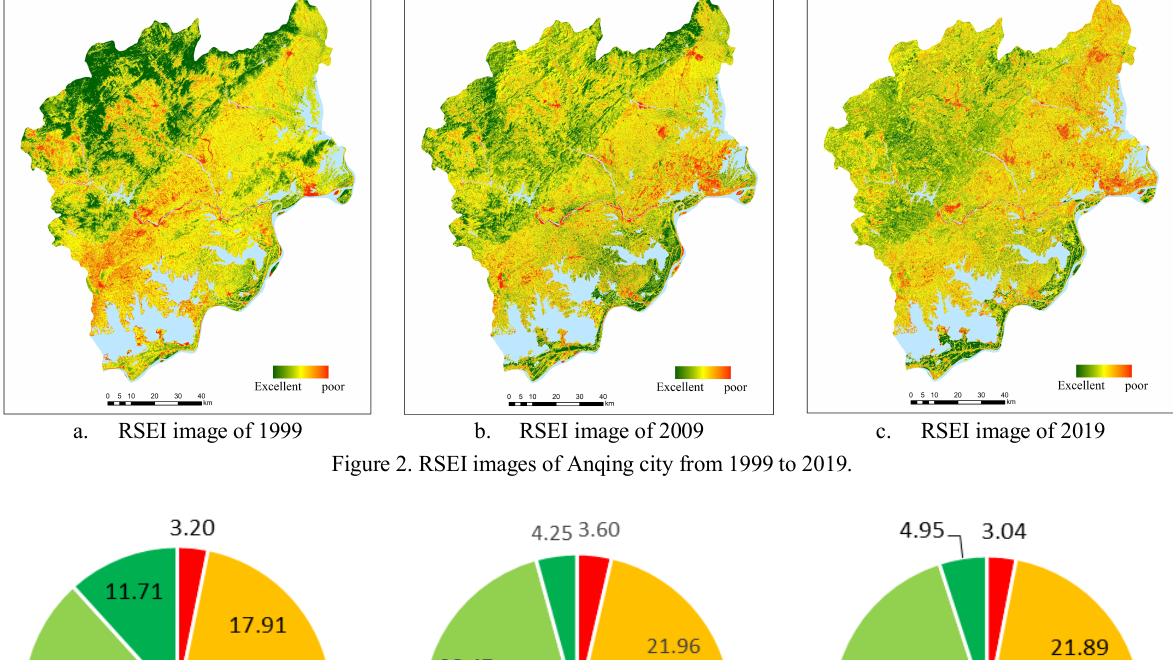
Figure 2. RSEI images of Anqing city from 1999 to 2019.